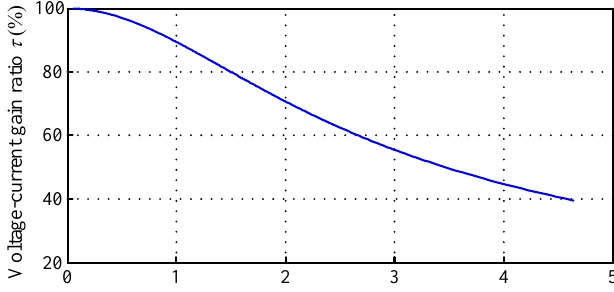
Figure 3. The voltage-current gain ratio curve.